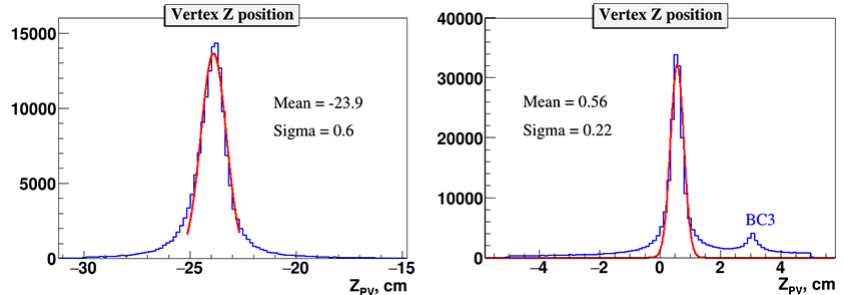
Figure 4. Reconstructed primary vertex along the beam: left) C + Al interactions, right) Ar + Al interactions. The small bump in the Ar -beam distribution is due to interactions in the trigger counter